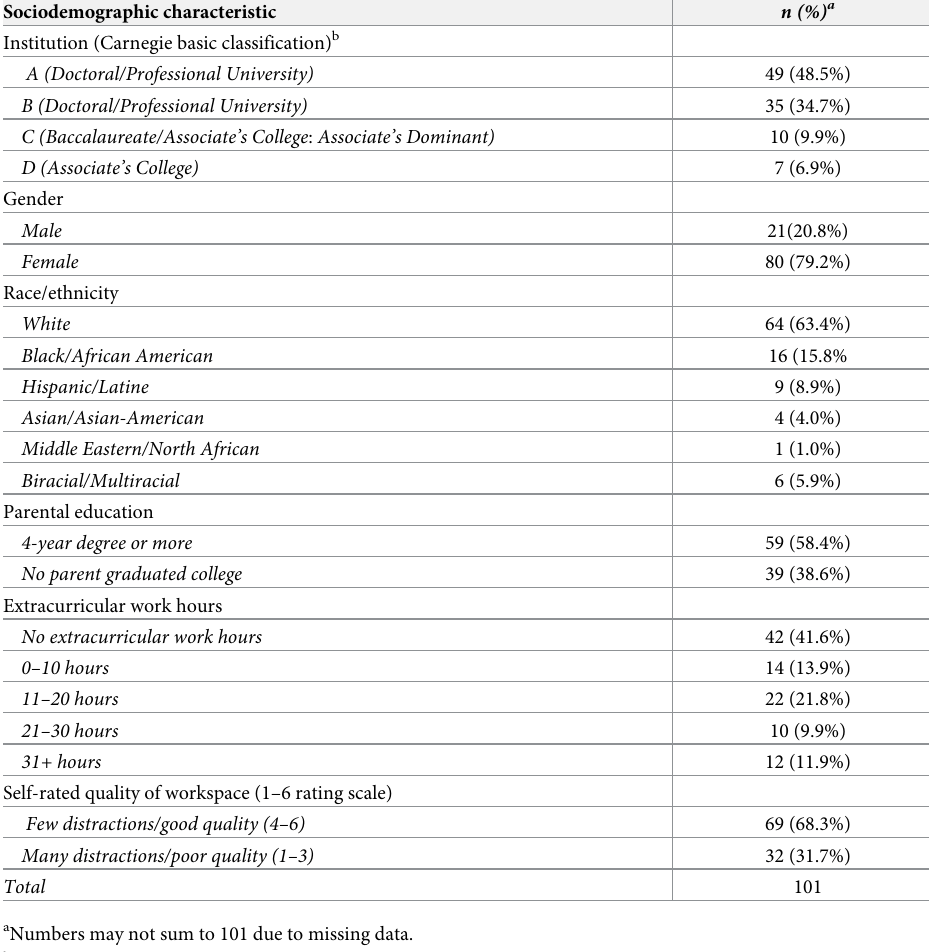
Table 1. Student self-reported sociodemographic